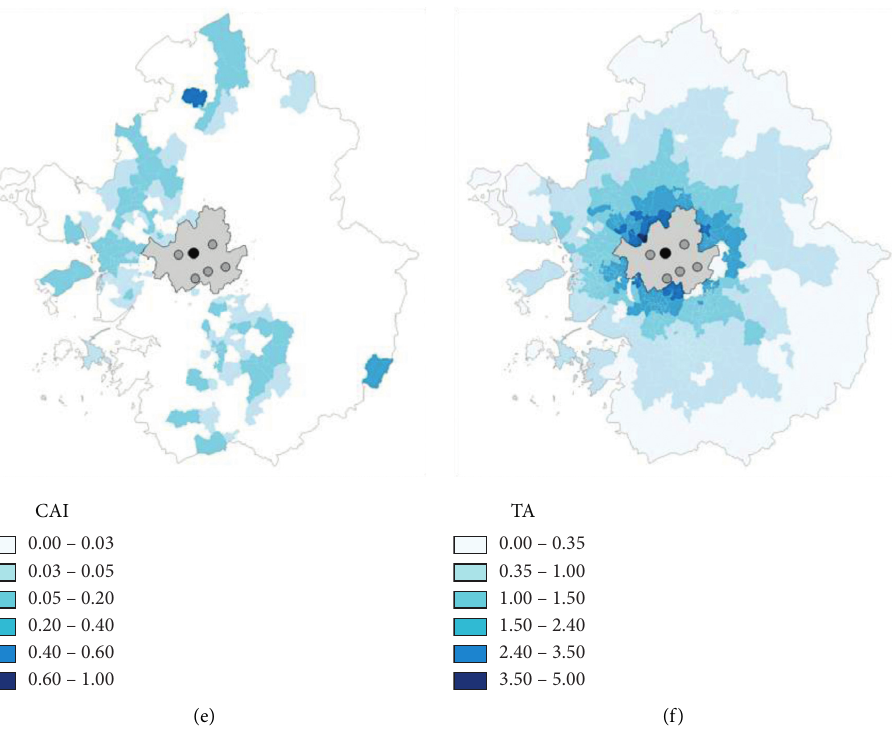
Figure 5: Comparison between CAI and TA of three transit centers: (a) CAI of Sadang; (b) TA of Sadang; (c) CAI of Gangnam; (d) TA of Gangnam; (e) CAI of Seoul Station; (f) TA of Seoul